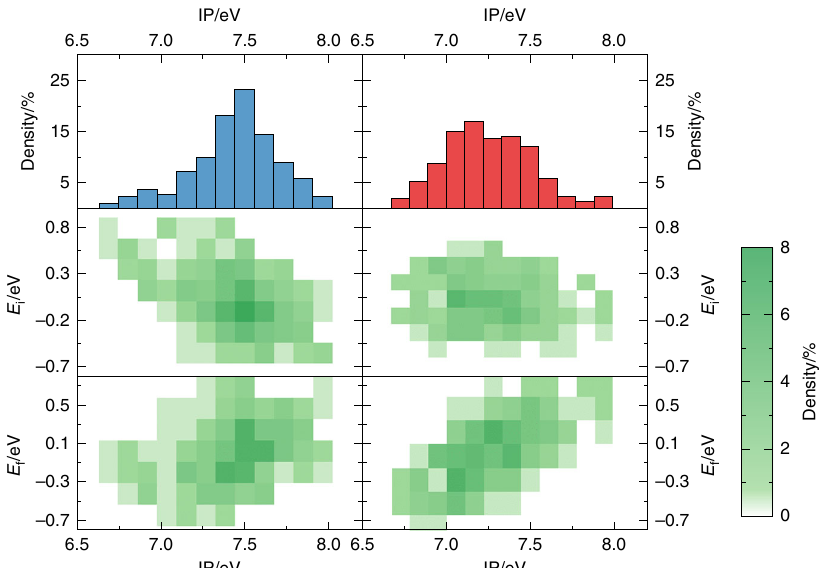
Fig. 1 IP distribution for 200 random con fi gurations of anion-solvent pair. The fi rst column corresponds to the (TFSI − , PC) pair, and the second column corresponds to the ( PF (cid:1) , DME) pair. Supplementary Information reports a full study for all anion-solvent pairs (Supplementary Fig. 3) with 30 6 con fi gurations. The color code, used consistently throughout this work, represents in blue con fi gurations where the anion is fully oxidized (all con fi gurations of the (TFSI − , PC) pair) and in red con fi gurations where the solvent is oxidized (all con fi gurations of the ( PF (cid:1) fi gures, we plot the heat maps of the initial (middle plot) and fi nal (bottom plot) energies for the two pairs. The energies are plotted relative to the average energy (either initial or fi nal)